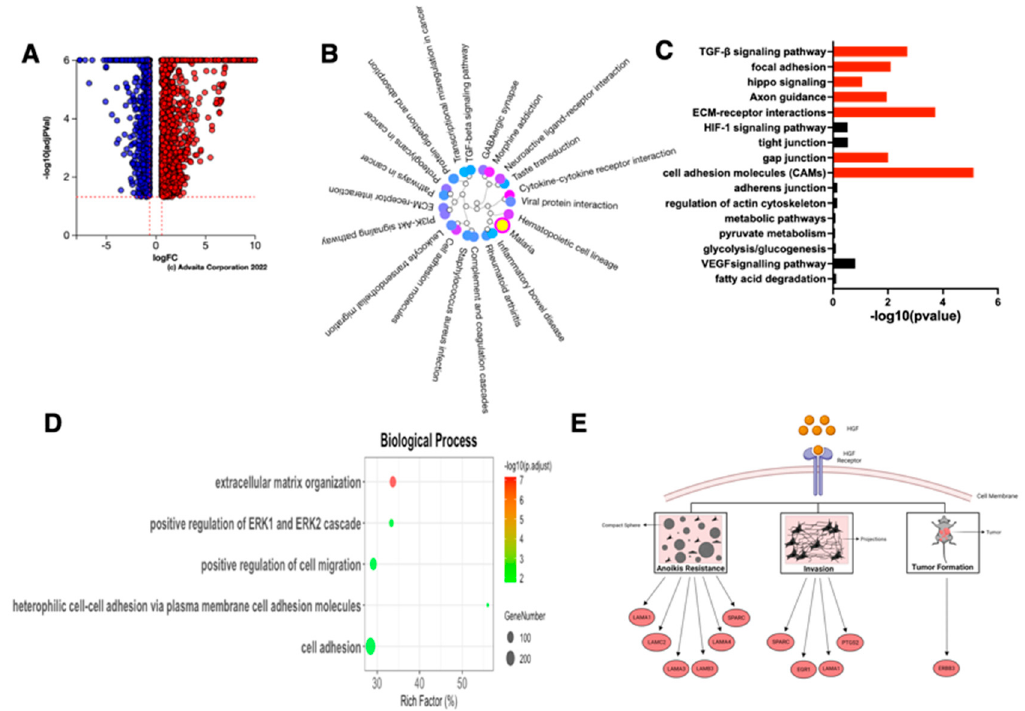
Figure 9. RNA-sequencing analysis of the HGF-treated E/M hybrid (HGFR182) compared to its epithelial counterpart (R182). ( A ) Volcano plot of DEGs; blue dots represent downregulated DEGs, red dots represent upregulated DEGs. ( B ) Dendrogram of significant biological pathways in the HGFR182 compared to R182 cells. ( C ) Bar plot of EMT related biological pathways in HGFR182 compared to R182 cells. Significant pathways are presented as red bars, and non-significant pathways as black bars. ( D ) GO terms for the analysis of biological processes in HGFR182 when compared to R182 cells. ( E ) Predicted scheme of the cellular phenotype observed with the analyzed DEGs when HGFR182 was compared to R182.